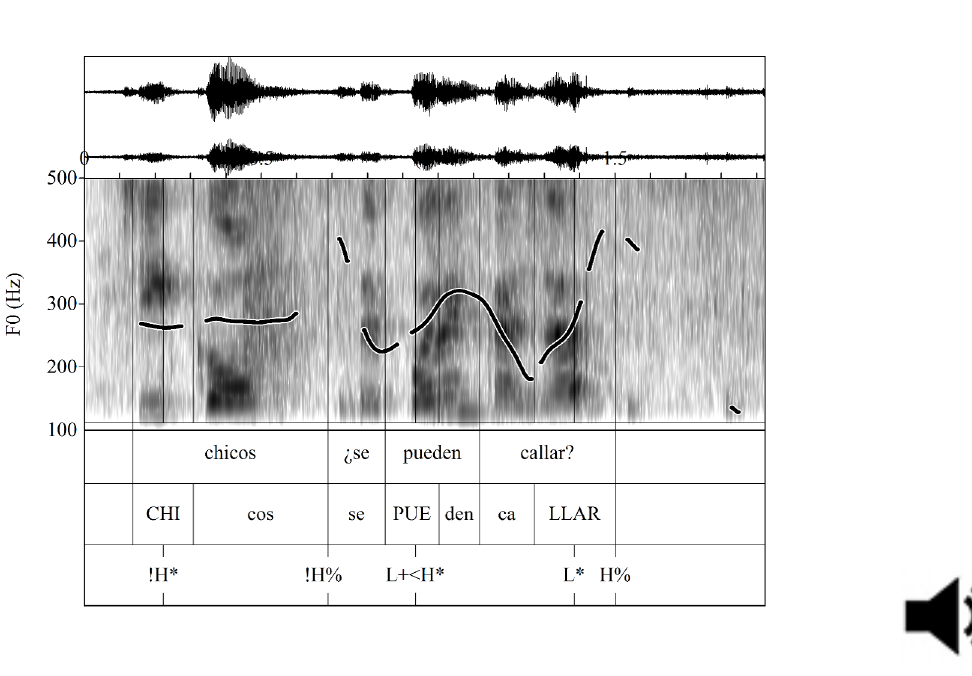
Figure 31 (Participant 11): Waveform and F0 trace for the vocative within the imperative yes-no question ¿ Chicos, se pueden callar? ‘Kids, can you please be quiet?’ produced as one IP realized as !H* (nuclear accent) and !H% (boundary